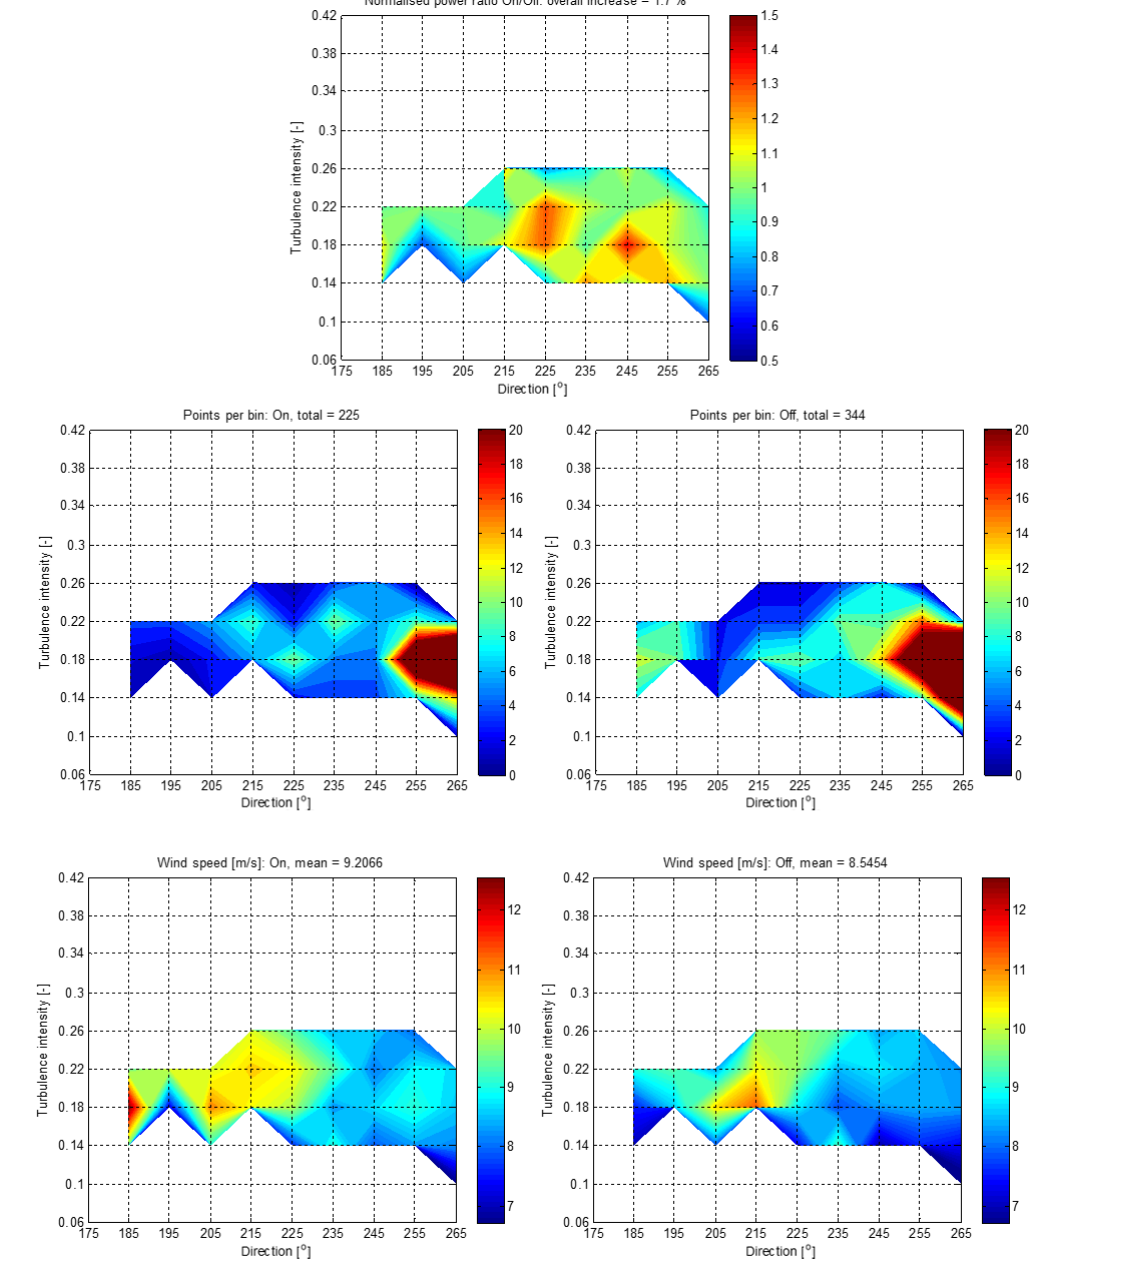
Figure 19. Normalised power ratio binned on turbulence intensity and direction.